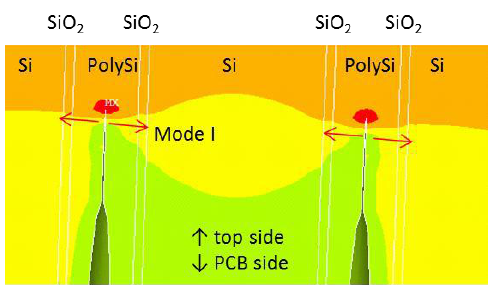
Figure 11. Illustration of the opening mode in poly-Si TSV.